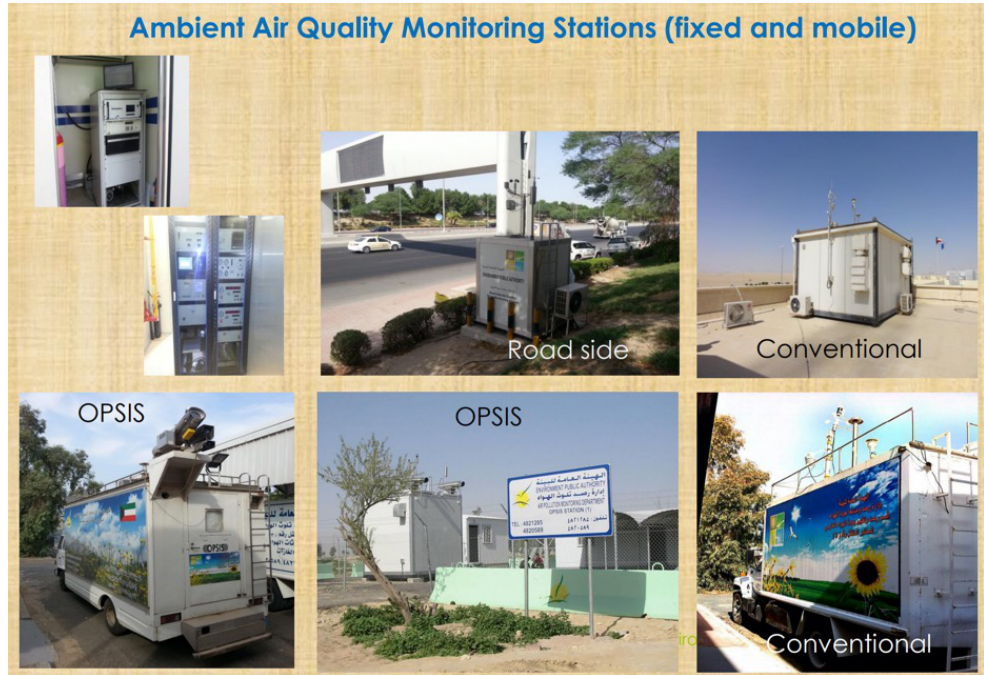
Figure 2. K-EPA mobiles lab and fixed stations used for air pollution